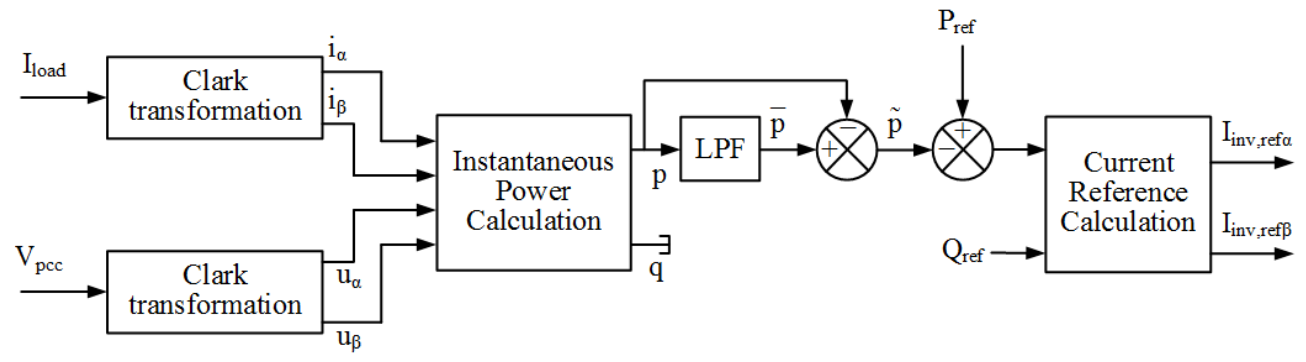
Figure 3. Inverter reference current estimation technique.